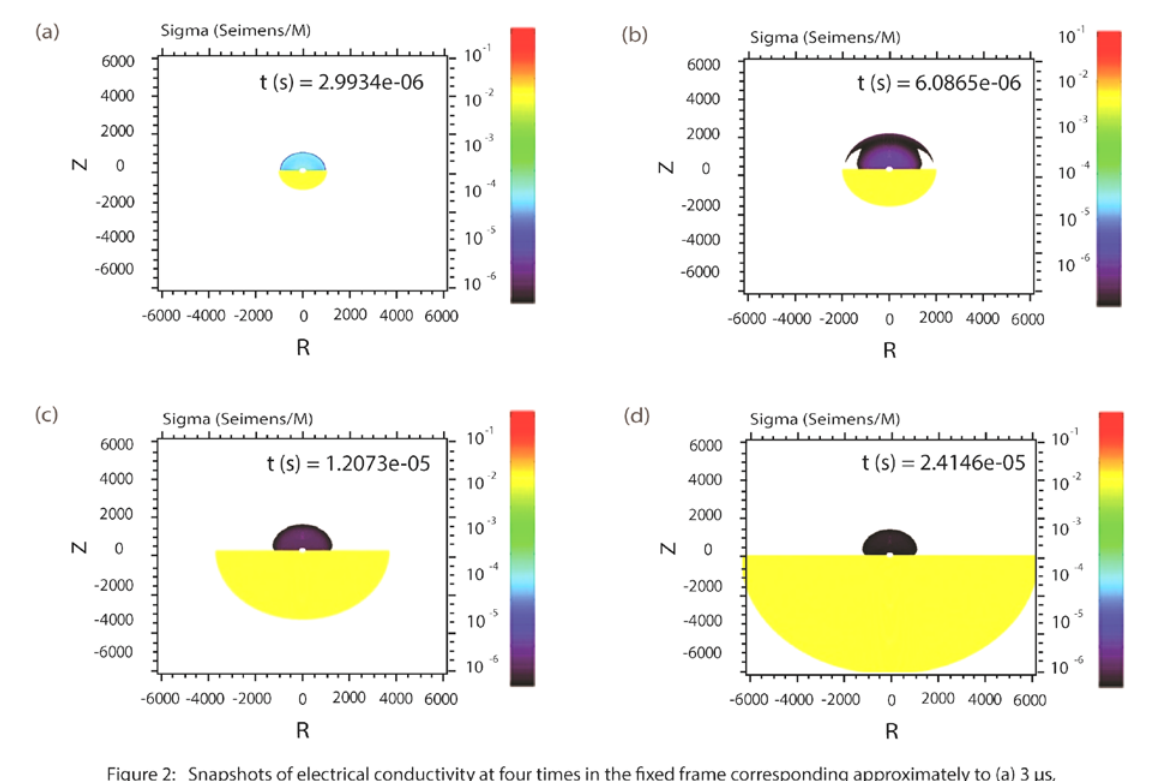
magnetic field strength in Tesla while the left hand side (LHS) shows the theta electric field magnitude in V/m. Note the strong negative electric field (positive in the z-direction) near the ground-air interface at ~ 1.5 km and ~3 km range in